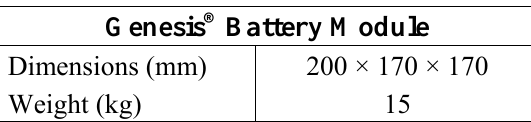
Figure 5. Gas Turbo-generator; L = 465 mm, D = 200 mm.